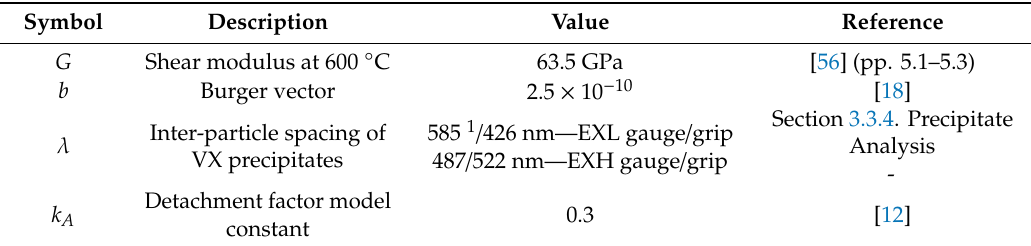
Table 6. Model inputs for the equation of threshold prediction by Arzt et al.